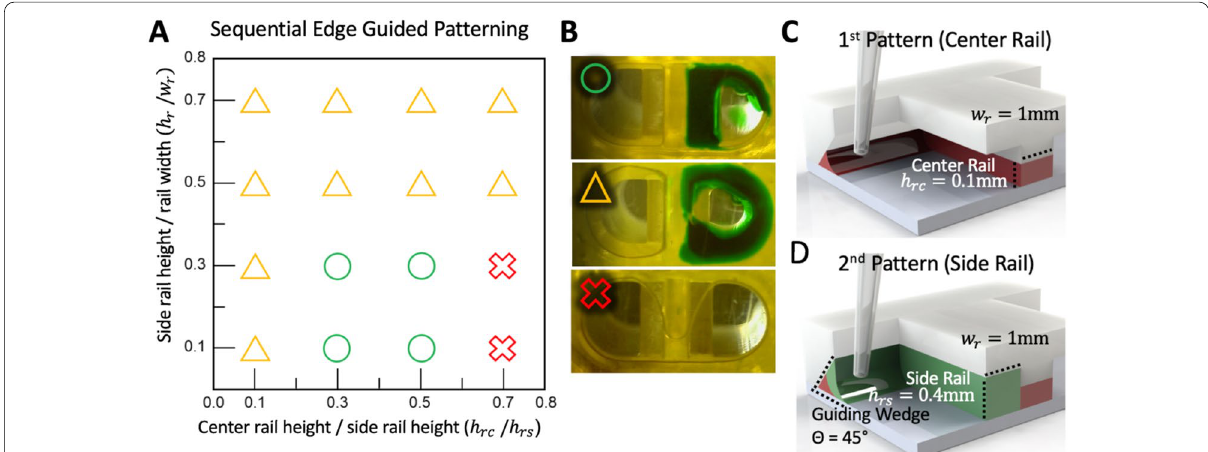
Fig. 2 Detailing the specifics of the novel sequential edge guided patterning mechanism. A A graph of the solution space of dimensions required for utilizing the wedge to rail capillary flow mechanism to sequentially pattern a primary central and secondary side rail utilizing the same wedge, for up to three (one central and two side) patterns within a unit chip. B Illustrates the success and failure conditions for patterning. The green circle denotes a successful 1st center rail and 2nd side rail patterning. The yellow triangle shows a successful 1st center rail patterning, but a failed 2nd side rail pattern due the inability for the 2nd pattern to fill the side rail. The red x denotes a 1st center rail pattern failure. C Shows a rendering of a successful 1st center rail patterning utilizing the optimized dimensions of the platform. D Shows a rendering of a successful 2nd side rail patterning utilizing the optimized dimensions of the